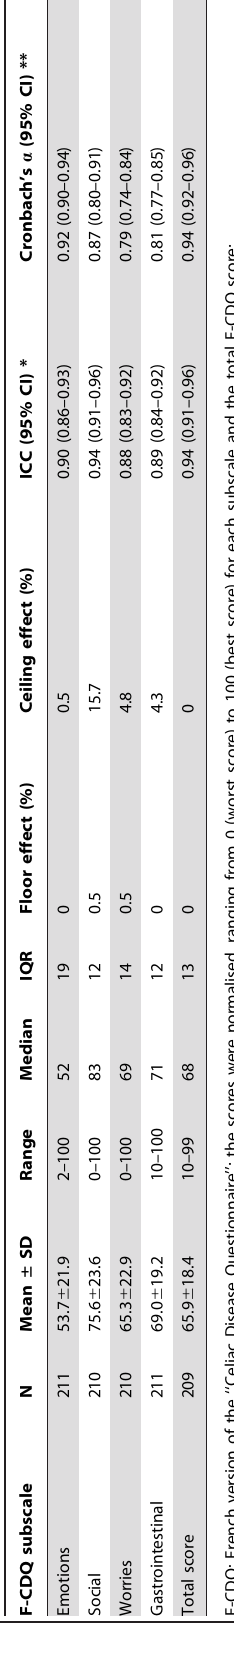
Table 1. Socio-demographic and clinical characteristics of the patients with celiac disease included in the validation study of the French version of the ‘‘Celiac Disease Questionnaire’’.